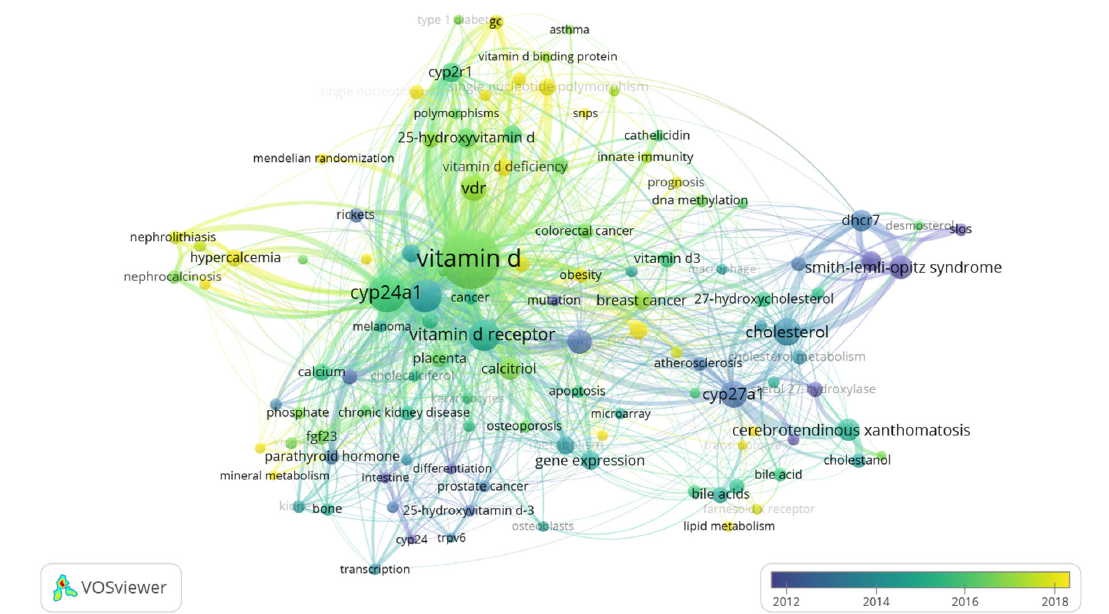
Figure 7. Overlay visualization of 114 most frequent author keywords. The average publication year for papers ranges from 2008 to 2019.